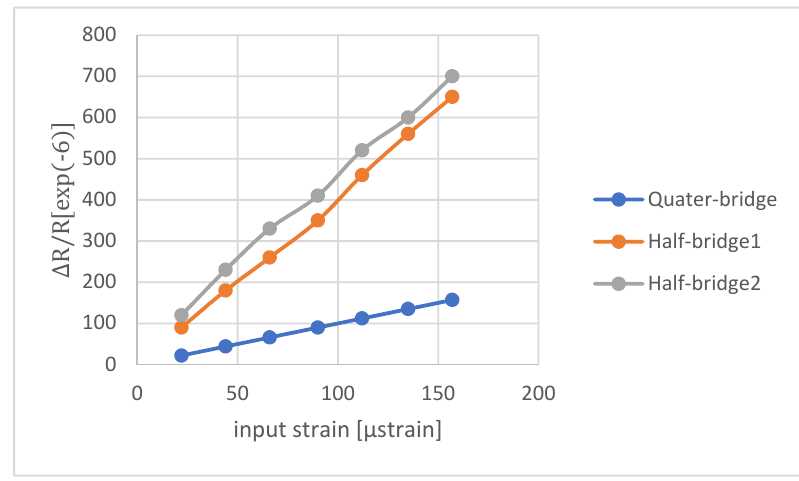
Figure 12. Sensitivity of quarter-bridge (2.16) and half-bridge (4.23) (435) circuit.